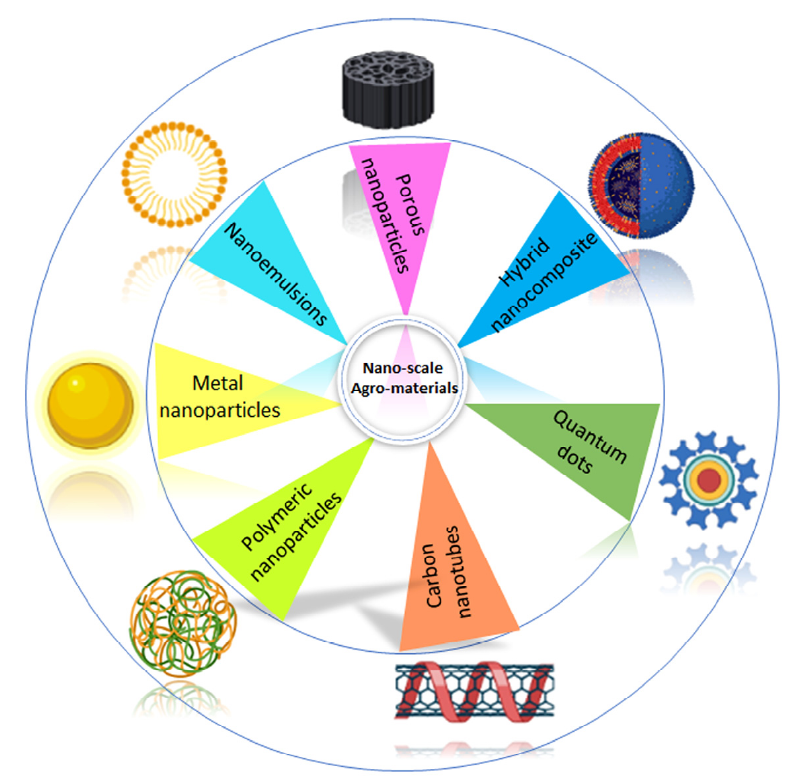
Figure 1. Schematics of different types of nanoscale agro-materials used in agriculture. Image partially created with BioRender.com.